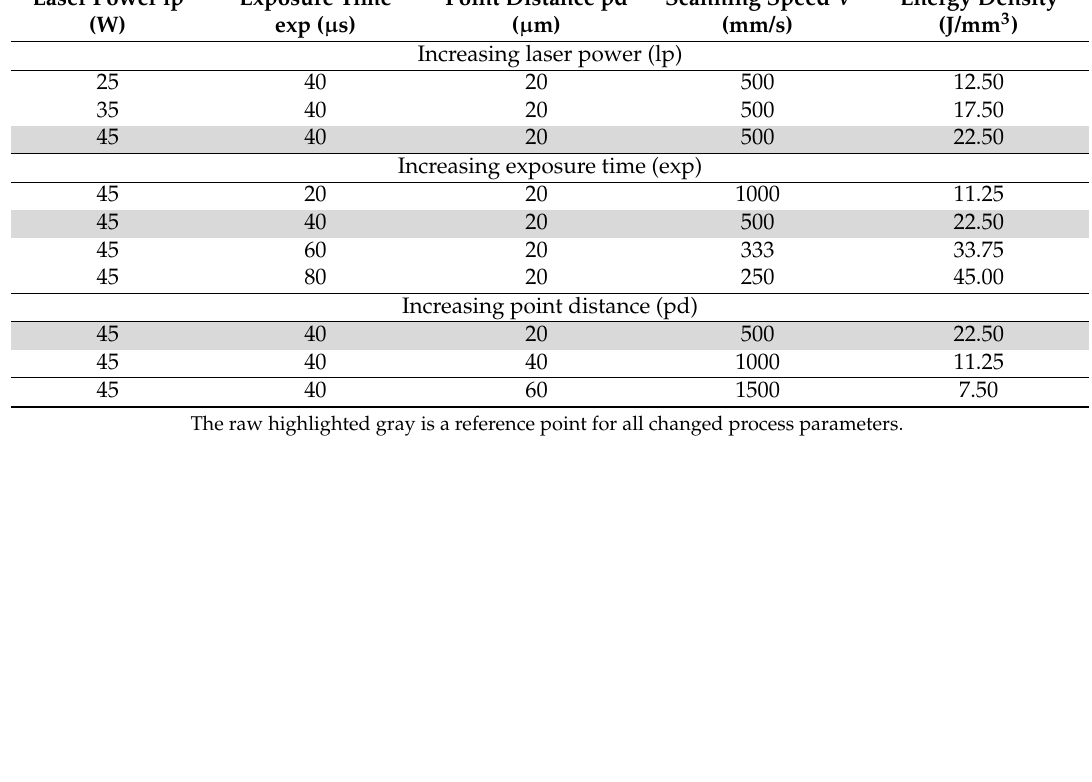
Table A1. Selective Laser Melting (SLM) process parameters used for titanium disc fabrication. Laser Power